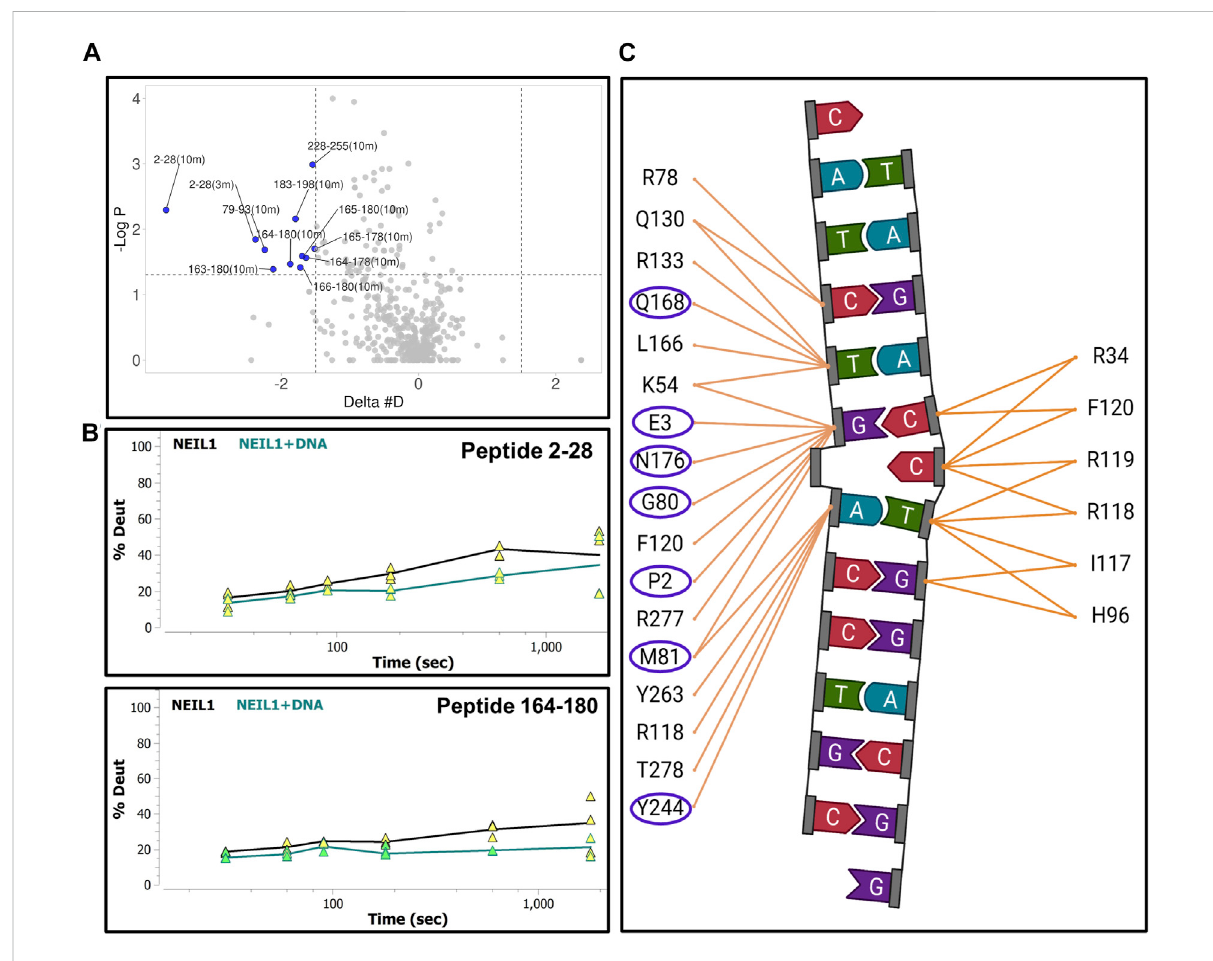
FIGURE 7 Hydrogen-deuterium exchange experiments for the NEIL1-DNA complex reveals regions of NEIL1 involved with DNA binding. (A) Volcano plot quantifying the signi fi cant change in deuteron uptake for each peptide at a given time point. The upper left quadrant displays peptides (solid blue circles) at various time points, representing a signi fi cant decrease in deuteron uptake upon DNA binding to NEIL1 relative to NEIL1 alone at a p -value of < 0.05 (please refer to the legend for Figure 5A for a detailed description of the statistical tests used). (B) Representative uptake plots are shown from the HDX-MS time course for two of the signi fi cant peptides, 2 – 28 and 164 – 180, that lie within the signi fi cant quadrant in panel (A) above. (C) Interaction map showing NEIL1 residues that interact with the DNA in the crystal structure of the NEIL1-DNA complex (PDB ID:5itt). The residues within the blue oval circles indicate those present in peptides with a signi fi cant decrease in deuteration, as observed in the volcano